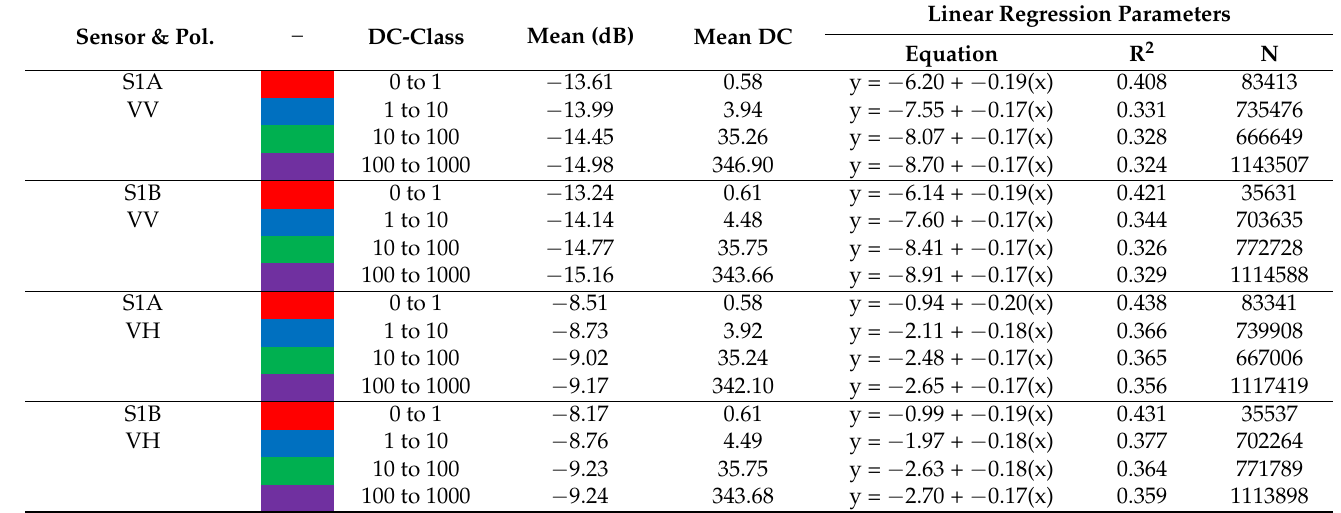
Table 1. Linear regression between C-VH backscatter values of unburnt pixels and LIA as a function of the sensor, polarization, and DC class. All the regressions have p << 0.001. The colors replicate the color scale in plots of Figure